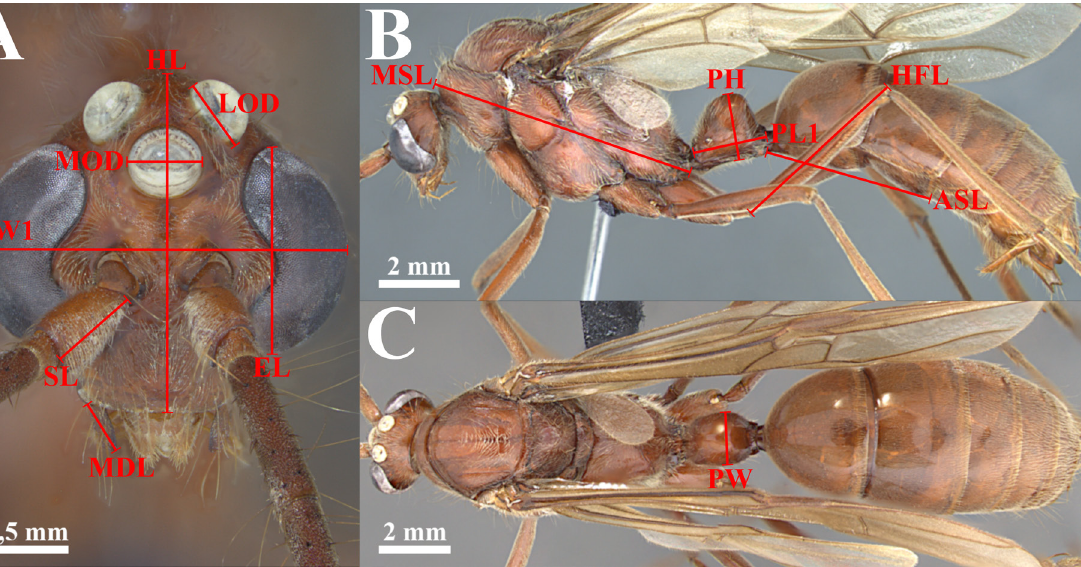
Fig. 1. Measurements of Dinoponera quadriceps Kempf, 1971, B . Full body in lateral view. C . Full body in dorsal view.